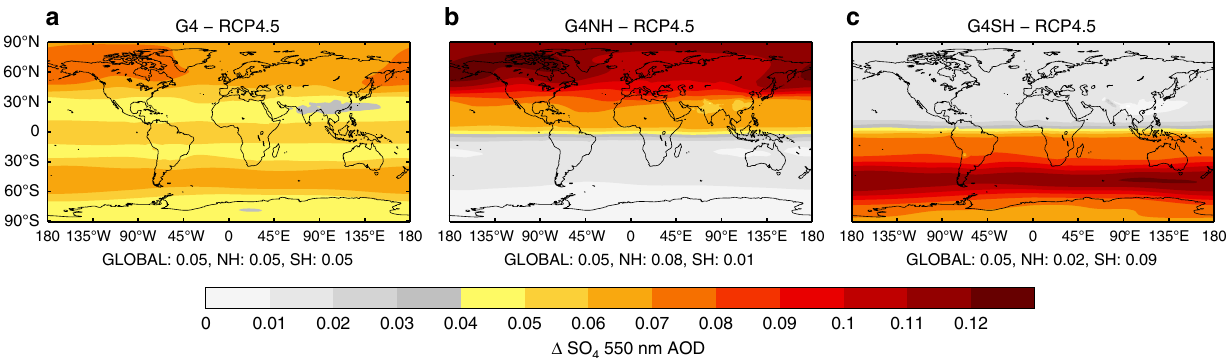
Fig. 2 Aerosol optical depth anomalies in the solar geoengineering simulations. Sulphate (SO 4 ) 550nm aerosol optical depth (AOD) anomaly 2020 – 2070 for a , global solar geoengineering (G4); b , northern hemisphere solar geoengineering (G4NH); and c , southern hemisphere solar geoengineering (G4SH) relative